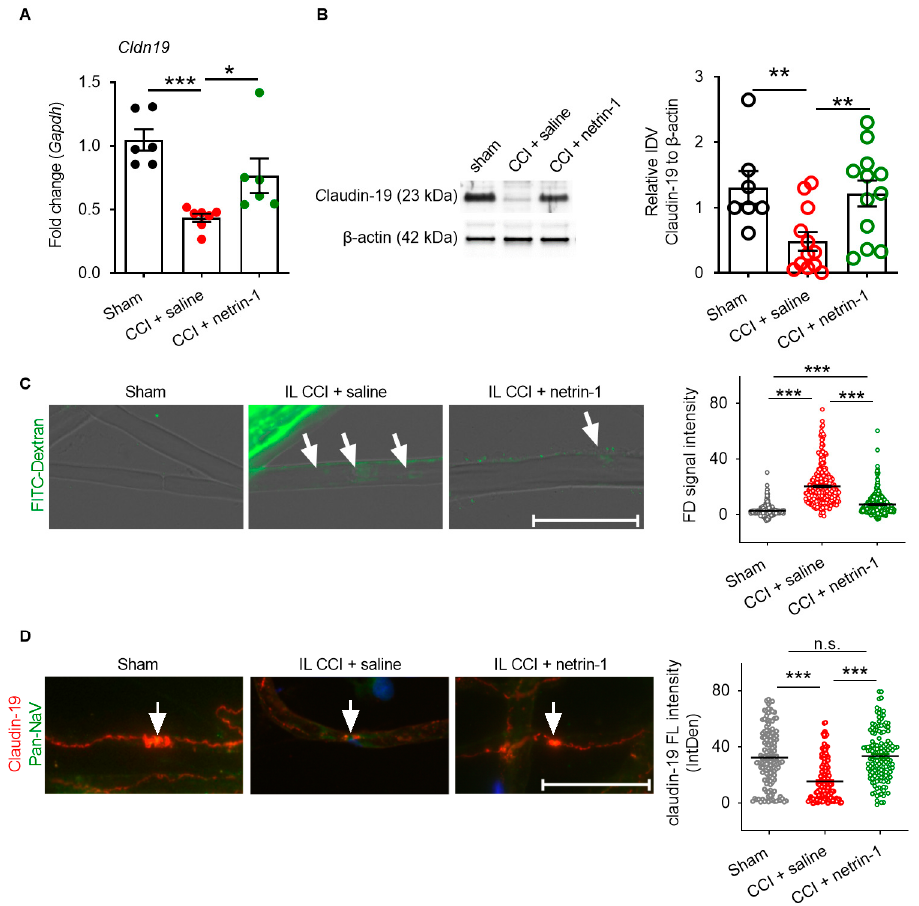
Figure 5. Netrin-1 rescues myelin barrier breakdown. Wistar rats with CCI were treated with daily i.p. netrin-1 injection. ( A , B ) Cldn 19 expression relative to Gapdh and protein relative to β -actin were measured in the sciatic nerve ( n = 6 and n = 7–12, respectively). ( C ) 70 kDa FITC-dextran leakage into teased nerve fiber was analyzed and quantified after ex vivo application of the dye at the sciatic nerve and subsequent fiber teasing (Arrow: FITC-dextran signal, 351–452 fibers from n = 5–7 rats/groups; Scale bars: 50 µ m). ( D ) Immunoreactivity for claudin-19 (red) and pan-NaV (green) was quantified in teased nerve fibers (Arrow: nodes of Ranvier; 137–161 fibers from n = 5–7 rats/group; Scale bars: 50 µ m). All mean ± SEM, Mann–Whitney U test, * p < 0.05, ** p < 0.01, *** p < 0.001, n.s.: not significant.